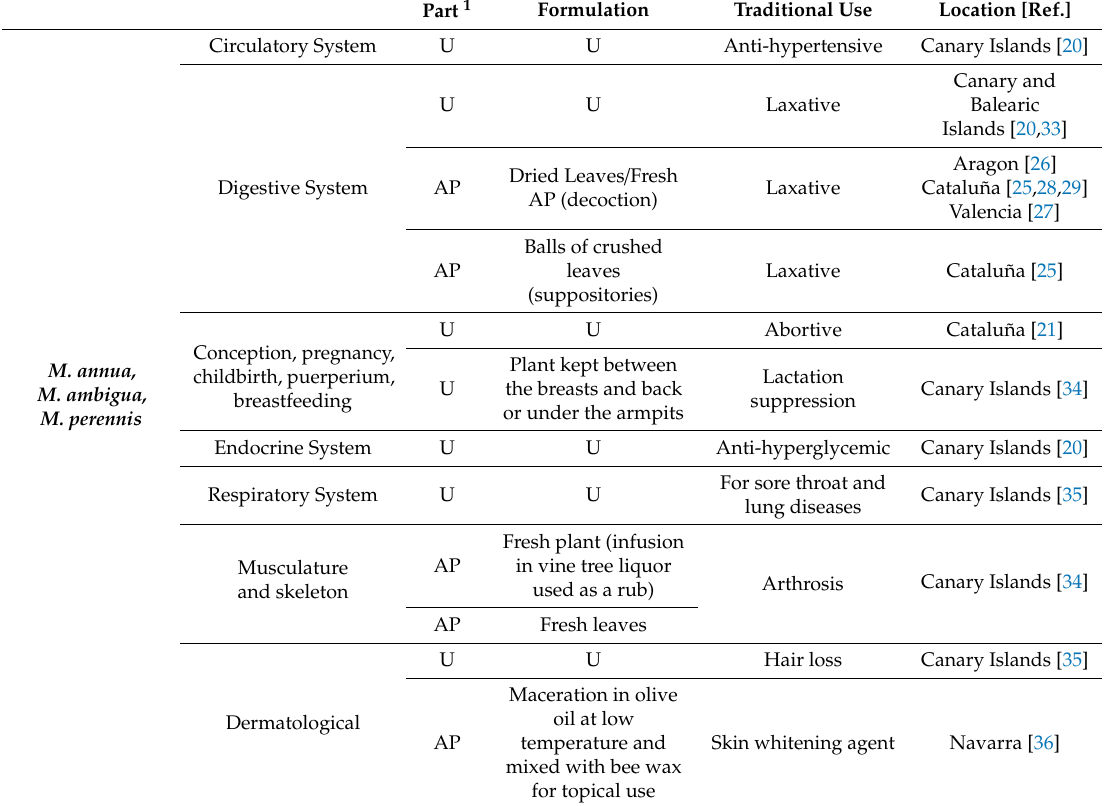
Table 1. Traditional uses of Mercurialis spp. in Spanish medicine. Part 1 Formulation Traditional Use Location